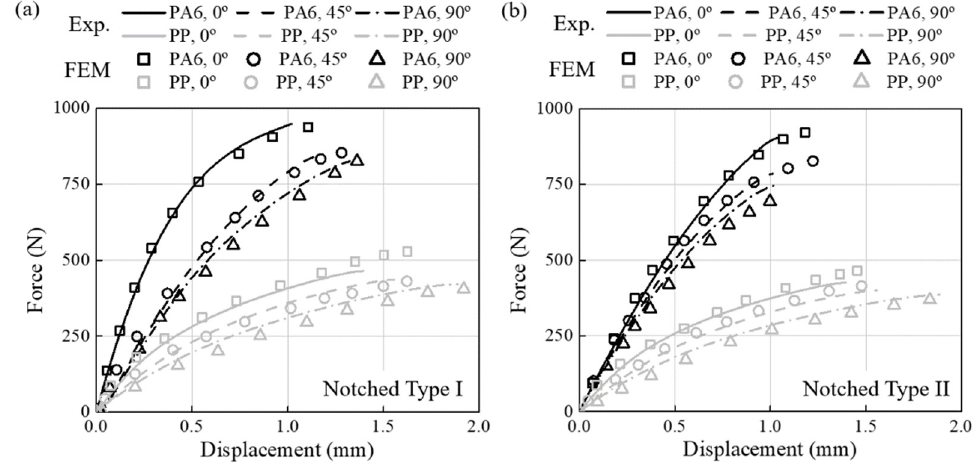
Figure 15. Load-displacement curves of PA6-CF and PP-CF materials (line: experimental data, scatter: FEM results). ( a ) The notched Type I. ( b ) The notched Type II.